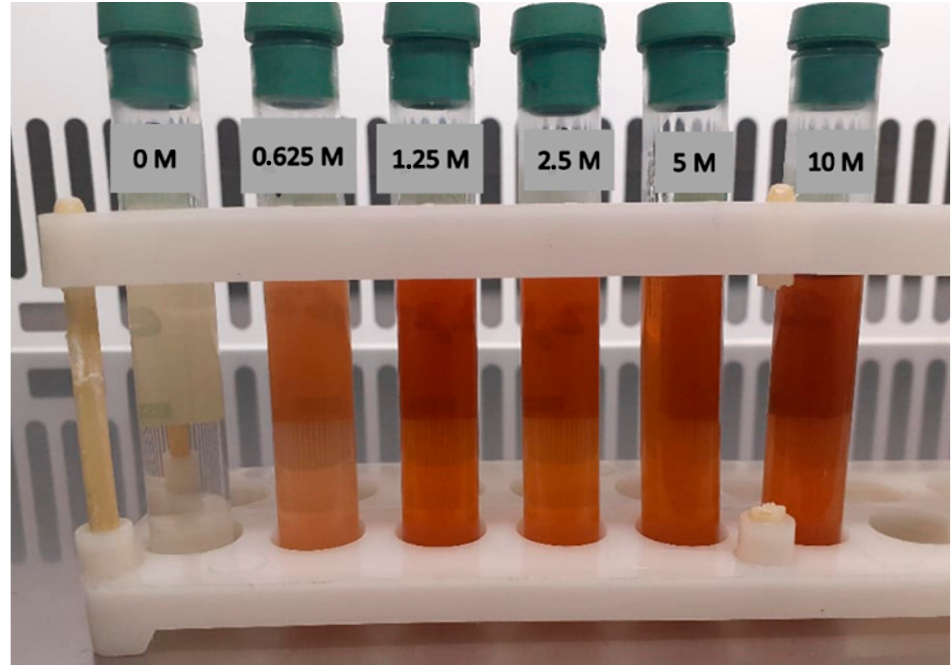
Figure 1. Color change after green synthesis of AgNPs with various concentrations of AgNO 3